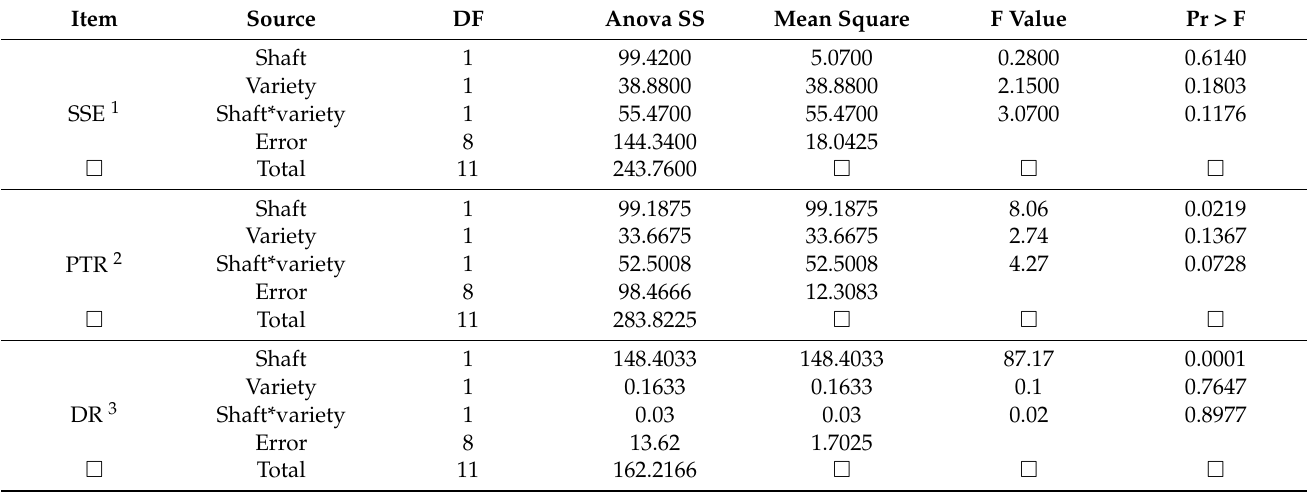
Table 6. Statistical results of field test based on shafts of drum type and variety of